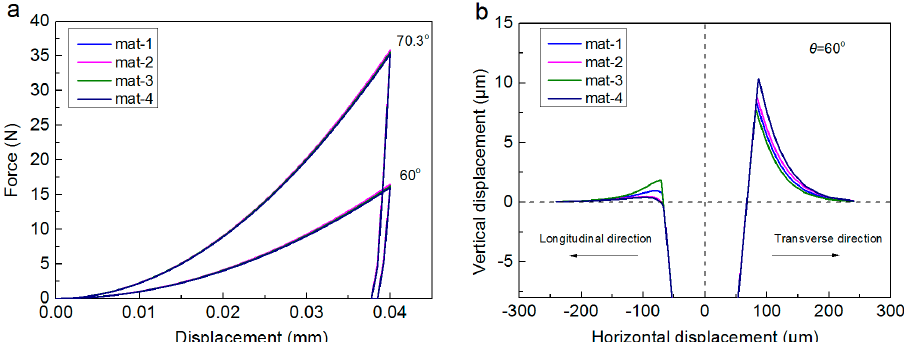
Figure 10. Indentation responses of the four “mystical materials”: ( a ) indentation P-h curves; ( b ) residual imprints along longitudinal and transverse directions.